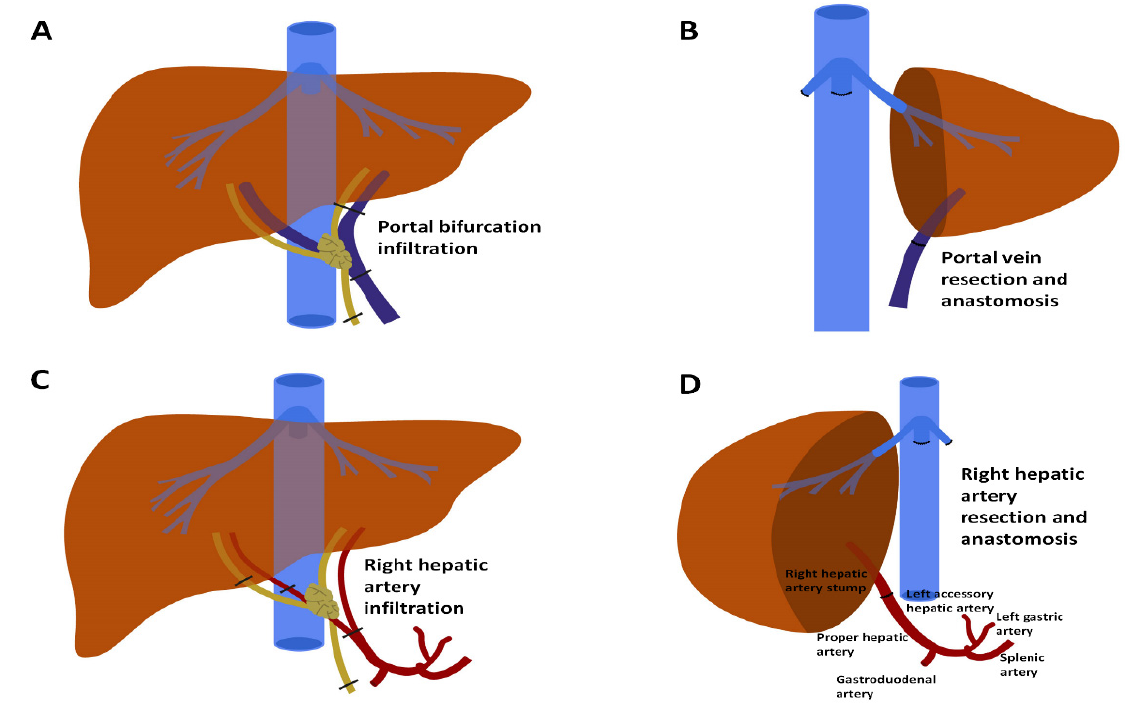
Figure 4. Resection and reconstruction for hilar cholangiocarcinoma involving portal vein or hepatic artery. ( A ) Hilar cholangiocarcinoma involving the portal bifurcation. ( B ) Resection has been performed, with portal end-to-end anasto- mosis. ( C ) Hilar cholangiocarcinoma involving the right hepatic artery. ( D ) Resection and reconstruction with end-to-end anastomosis between the right hepatic artery stump and the proper hepatic artery. Reconstruction is also possible using a rotating arterial graft with any of the named arteries in the picture. Finally, reconstruction with a radial artery graft or a saphenous vein graft is also possible (not depicted).